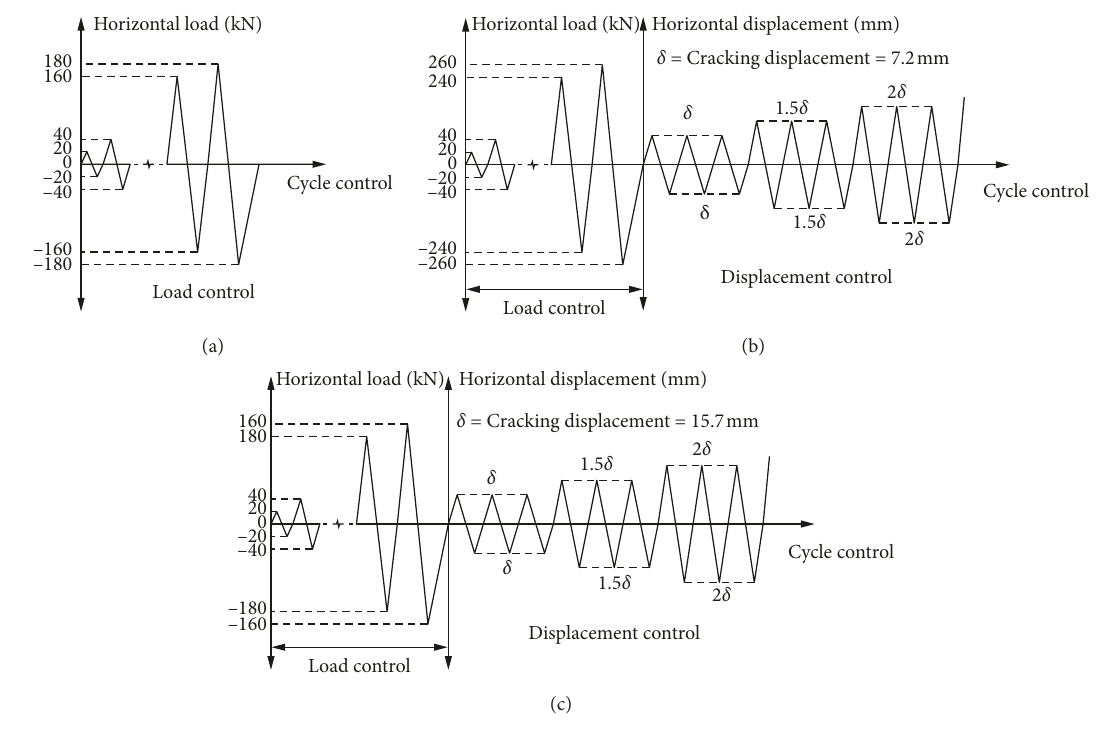
Figure 7: Test loading system: (a) UWF, (b) TMWF, and (c) PDWF.